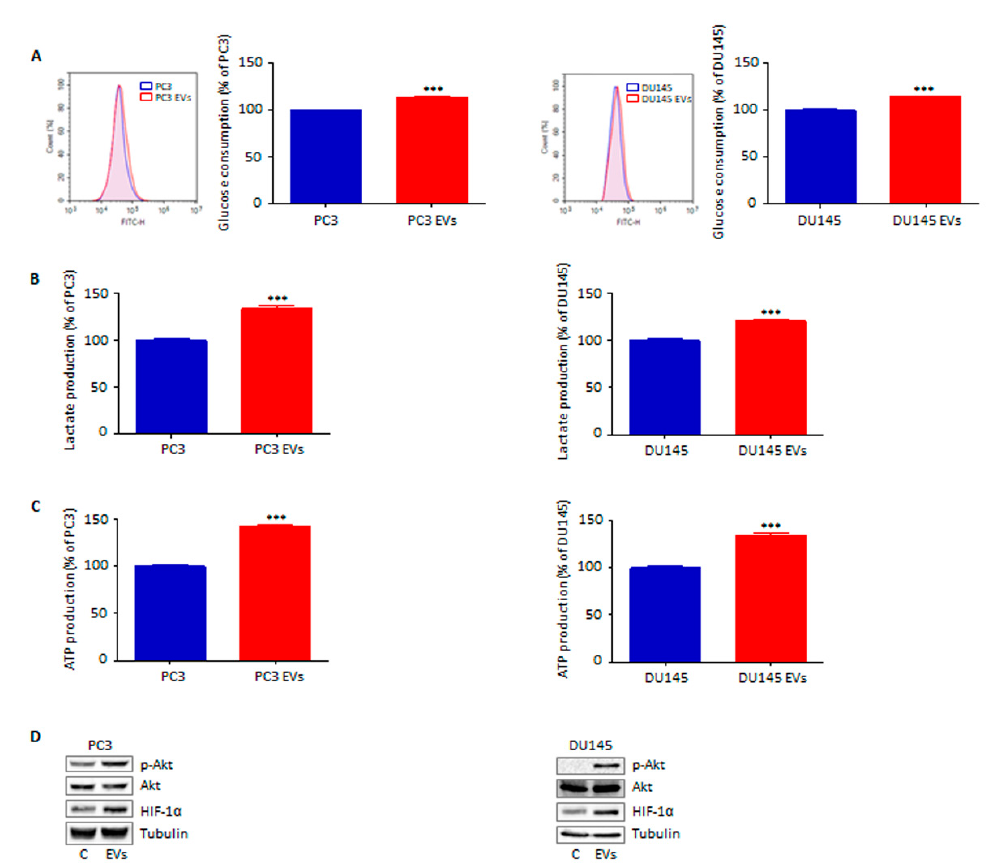
Figure 5. Extracellular vesicles from adipocytes reprogram prostate cancer cell metabolism. ( A ) PC3 and DU145 cells were incubated with adipocyte-derived EVs (30 μ g/mL) for 24 h. Glucose consumption was then evaluated by cytofluorimetric analysis after staining with 2-(N-(7-Nitrobenz- 2-oxa-1,3-diazol-4-yl)amino)-2-Deoxyglucose (100 μ M) for 30 min. Each experiment was repeated three times. Data represent mean values ± SEM and were analyzed using a t-test. *** p < 0.001 vs. PC3 or DU145 (control). ( B ) Cells were incubated with adipocyte-derived EVs (30 μ g/mL) for 24 h. Lactate production was then evaluated by using a lactate assay kit (according to the manufacturer’s protocol). Each experiment was repeated three times. Data represent mean values ± SEM and were analyzed using a t-test. *** p < 0.001 vs. PC3 or DU145 (control). ( C ) Cells were incubated with adipocyte-derived EVs (30 μ g/mL) for 24 h. ATP synthesis was then evaluated by using an ATP assay kit (according to the manufacturer’s protocol). Each experiment was repeated three times. Data represent mean values ± SEM and were analyzed using a t-test. *** p < 0.001 vs. PC3 or DU145 (control). ( D ) After adipocyte-derived EV treatment (30 μ g/mL, 24 h), Western blot analysis was performed to investigate the expression levels of p -Akt and HIF-1 α in PC3 and DU145 cells. Tubulin expression was evaluated as a loading control. One representative of three experiments performed is